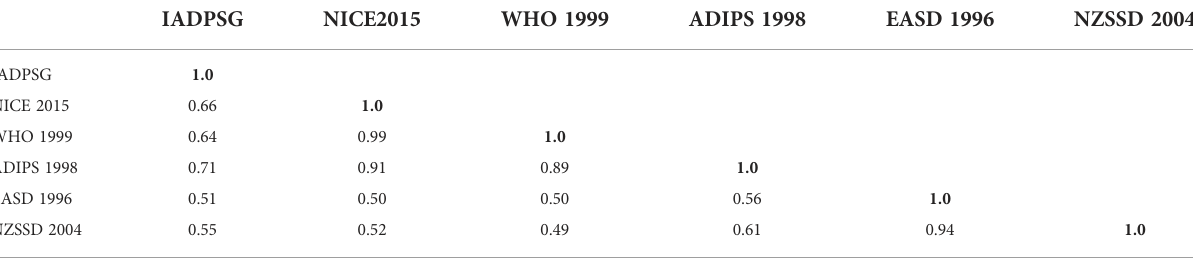
TABLE 5 Comparing agreement between diagnostic criteria (in pairs) using k statistics.